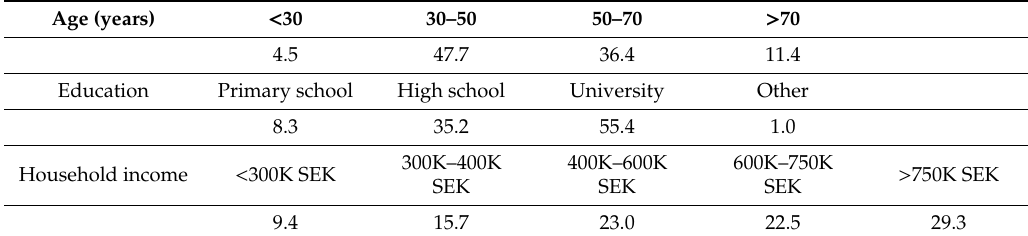
Table 3. Distribution (percentage) of socioeconomic characteristics for high interested respondents.